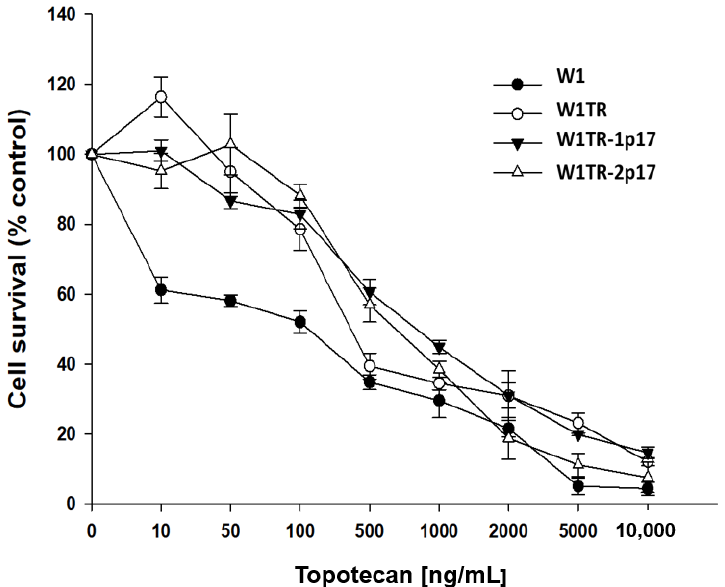
Figure 10. MTT cell survival assay in 3D cell culture conditions in W1, W1TR, W1TR-1p17 and W1TR-2p17 cell lines. Cells were seeded in 96-well plates with non-adherent surface and